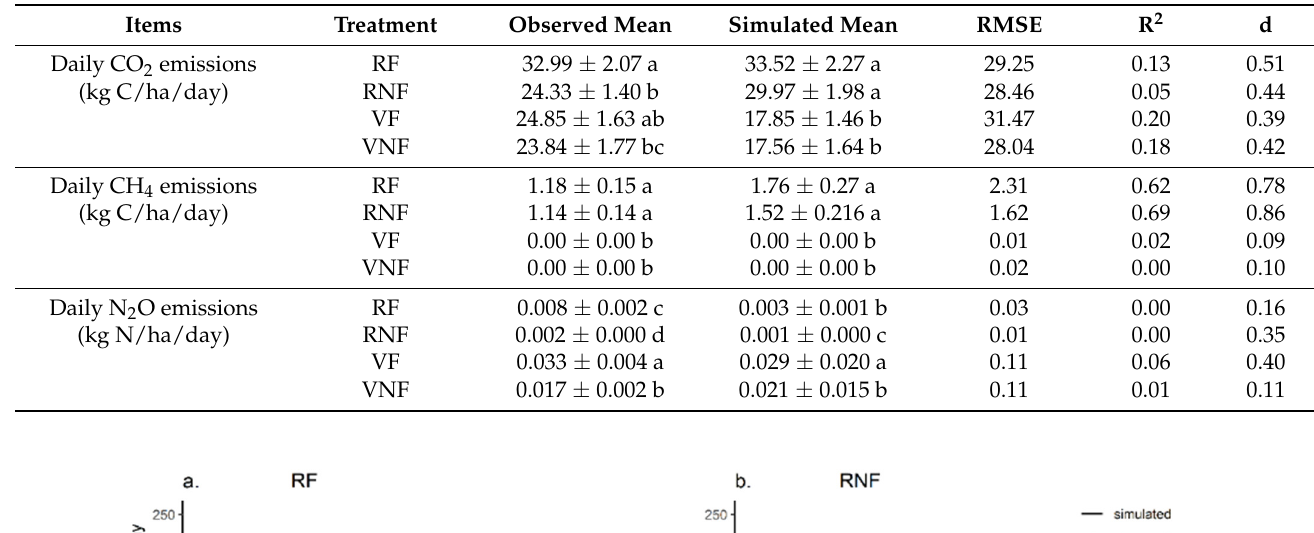
Table 3. Statistics for the observed and simulated daily CO 2 , CH 4 and N 2 O emissions under the different cropping systems and fertilization levels. RF: rice with fertilization; RNF: rice without fertilization; VF: vegetable with fertilization and VNF: vegetable without fertilization; RMSE is root mean square error; R 2 is coefficient of determination; d is d-index [40]. Different letters within a cultivar indicate significant differences between groups ( p < 0.05).